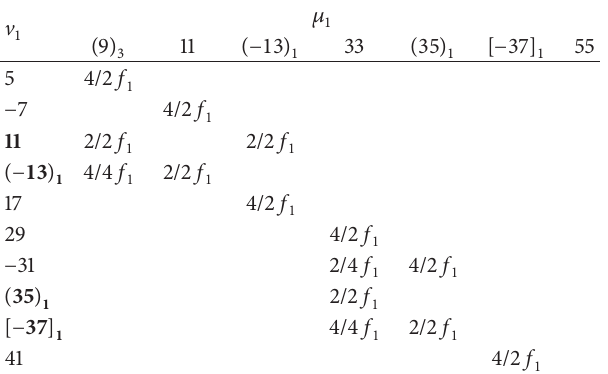
Table 2: Main electromagnetic force with 22 Poles and 24